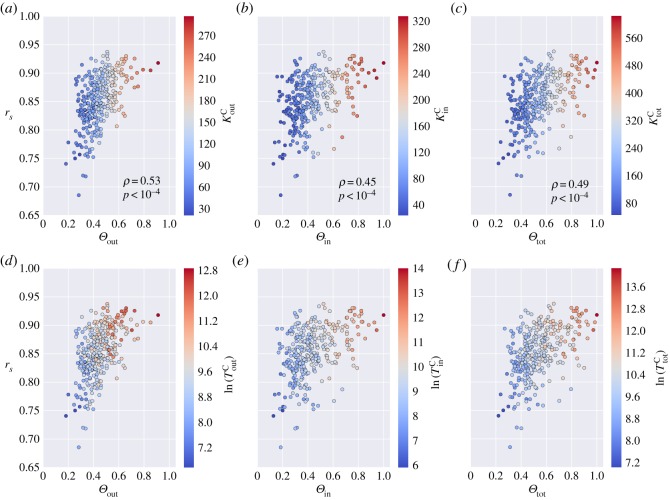
Comparing the correlation of arrival times and loyalty. Each panel shows the Spearman’s correlation coefficient measured between the arrival times on the census network and the mobile phone network against the loyalty of the seed node: (a,d) Θin, (b,e) Θout, (c,f) Θtot. Points are scatter plot for each node of the network that seeded the epidemic. Colour gradient, from blue to red, represents increasing values of (a) KoutC, (b) KCin, (c) KCtot, (d) TCout, (e) TCin, (f) TCtot. Traffic values are shown on a log scale.